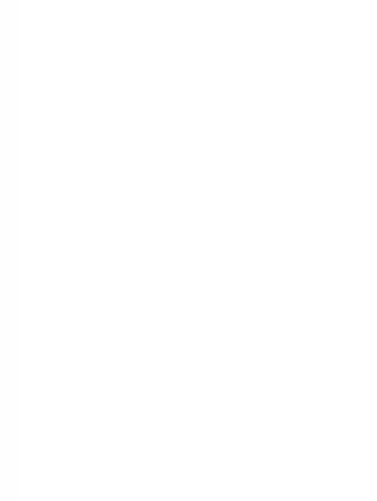
Figure 3. Signal constellation of the DSSS-PN QPSK noise-free transmit signal, colour coded for each position in a quadrant.